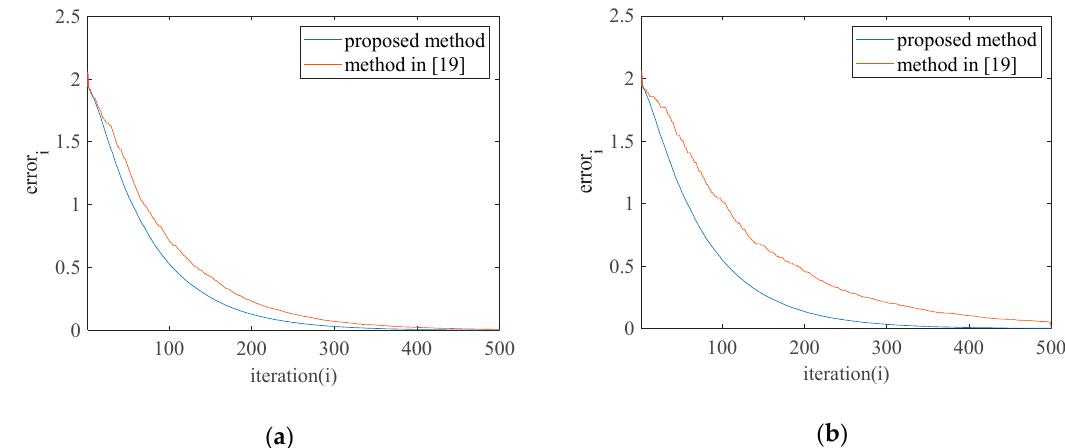
Figure 10. Comparison results with other method: ( a ) 20% packet loss; ( b ) 50% packet Figure 10. C omparison results with other method: ( a ) 20% packet loss; ( b ) 50% packet loss.